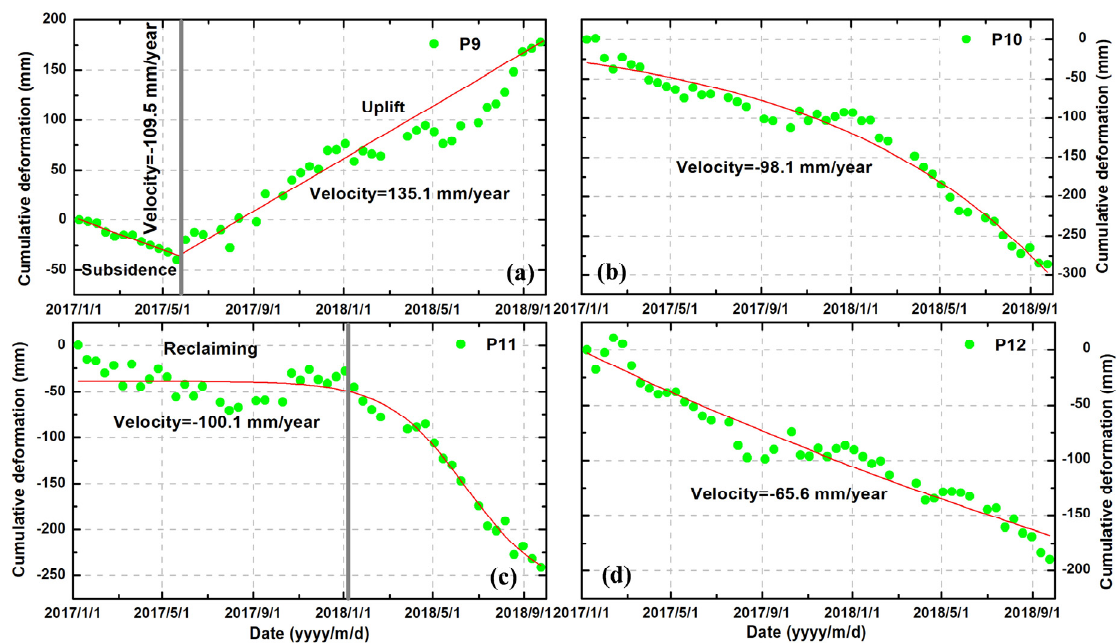
Figure 11. Time series deformation in the vertical direction of Regions E and F from January 2017 to October 2018 for P9–P12, which are indicated as white dots in Figure 9b. ( a ) Point P9; ( b ) point P10; ( c ) point P11; ( d ) point P12.